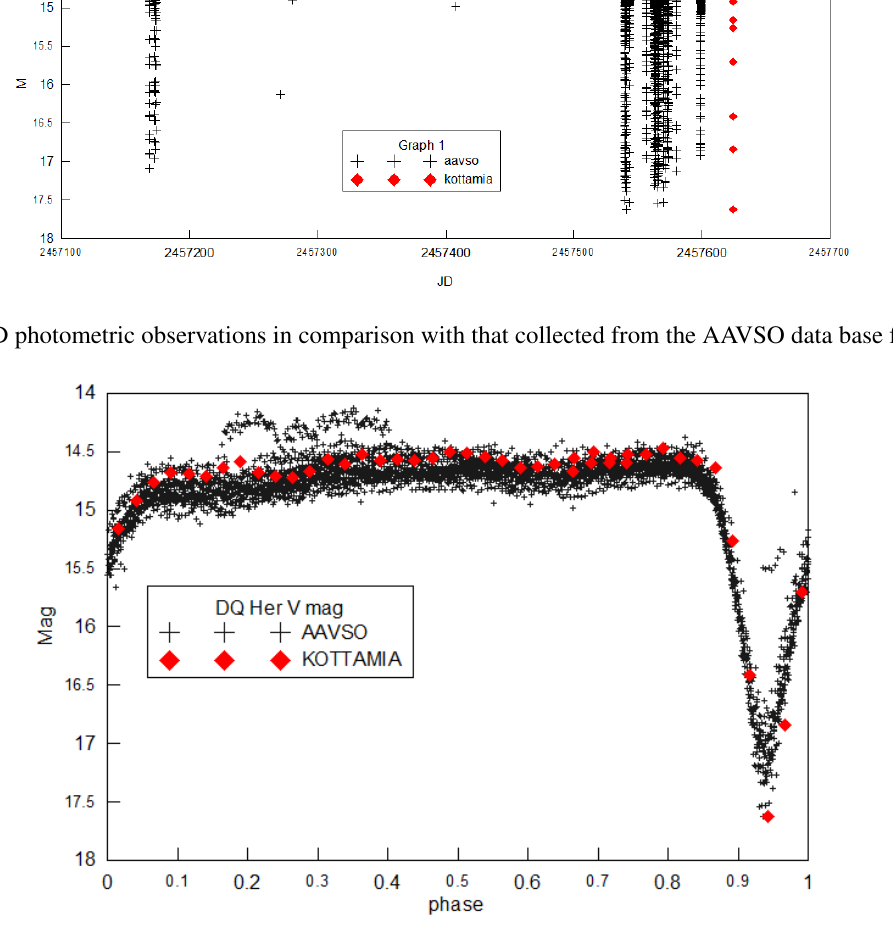
Fig. 7 DQ Her observed phase diagram in comparison with that collected from the AAVSO data base